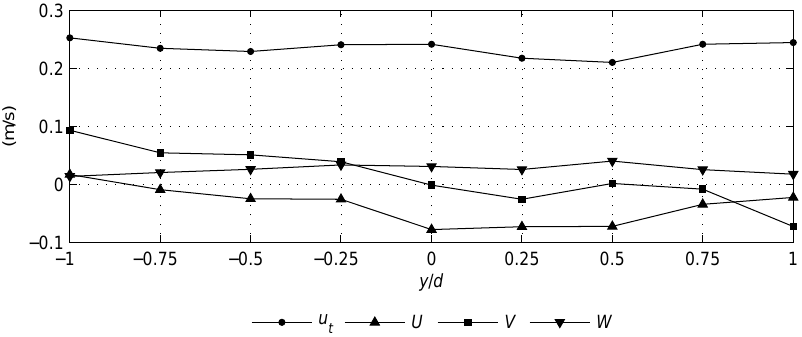
Figure 4. Transect of turbulent velocity, u t , and mean velocity components ( U , V and W ) at x = 0, − 1 ≤ y / d ≤ 1, z =